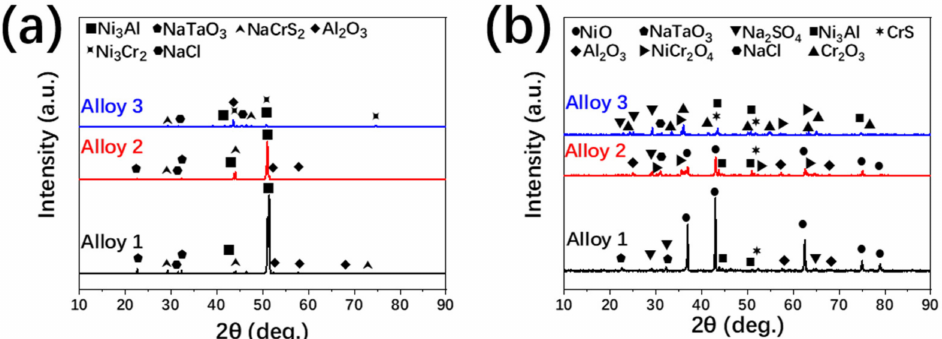
Figure 5. The XRD patterns of the corrosion products developed on the surface of the specimens after the corrosion experiments at 900 ◦ C in 200 h for ( a ) tube-sealing and ( b ) no